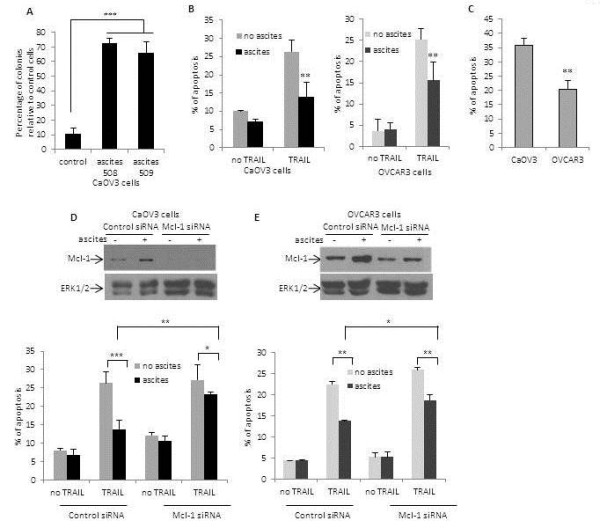
Mcl-1 inhibition abrogates the prosurvival activity of ascites. (A) The effect of ascites on CaOV3 cell survival was assessed by long term assays where cells were exposed to TRAIL (50 ng/ml) for 24 h in the absence (control) or presence of ascites (10%). After 14 days colonies were counted and expressed as percentage of colonies obtained in the absence of TRAIL. (B) The percentage of apoptosis was measured as percentage of hypodiploid cells assessed by flow cytometry analysis during exposure to TRAIL (50 ng/ml for CaOV3; 100 ng/ml for OVCAR3) for 24 h in the presence or absence of OVC508 ascites. (C) CaOV3 and OVCAR3 cells were treated with a similar concentration of TRAIL (50 ng/ml) and apoptosis was assessed by flow cytometry 24 h later. (D) CaOV3 and (E) OVCAR3 cells were transfected with Mcl-1 or control siRNA in the presence or absence of OVC508 ascites. Mcl-1 knockdown was confirmed by immunoblot analysis 24 h after transfection and ERK1/2 was used as a loading control. Apoptosis was assessed 24 h following siRNA transfection in the presence or absence of TRAIL (50 ng/ml). Data shown are means ± SEM derived from three independent experiments. * indicates P < 0.01, ** P < 0.001, *** P < 0.0001.